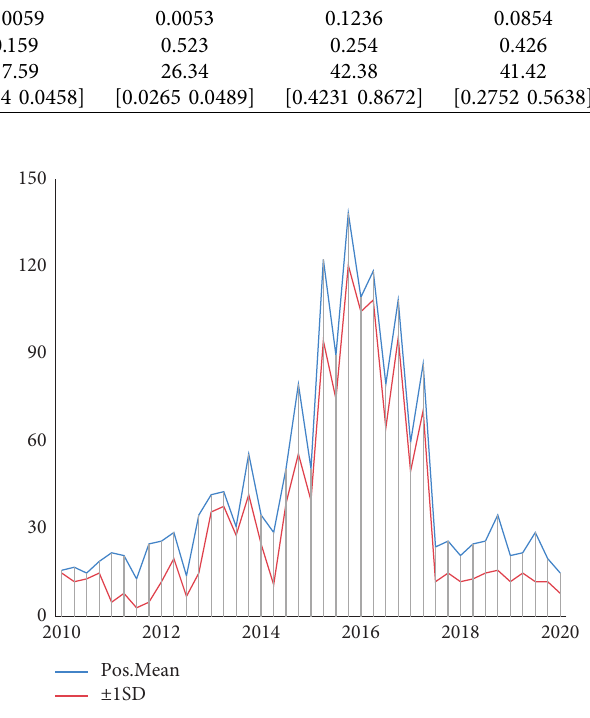
Figure 8: Time-varying features of stochastic price volatility for EM